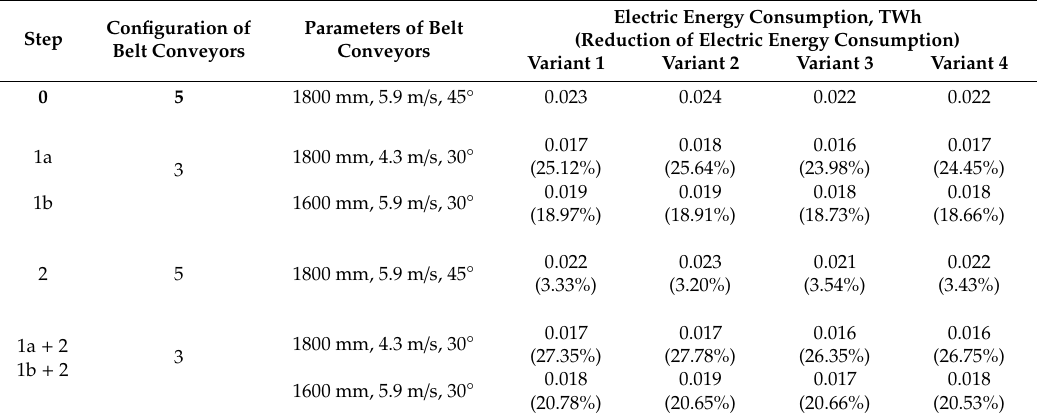
Table 4. Electric energy consumption and reduction of annual electric energy consumption of the proposed conveyor transportation system.